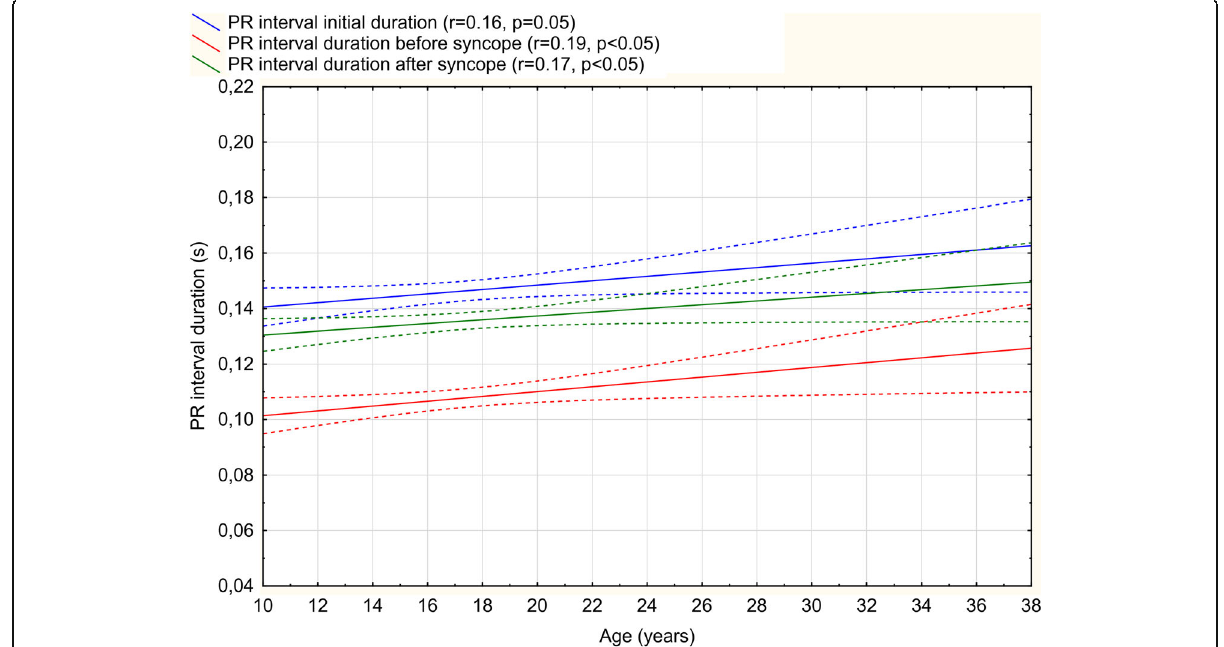
Fig. 3 PR interval duration at the beginning of the test, before and after syncope onset according to age